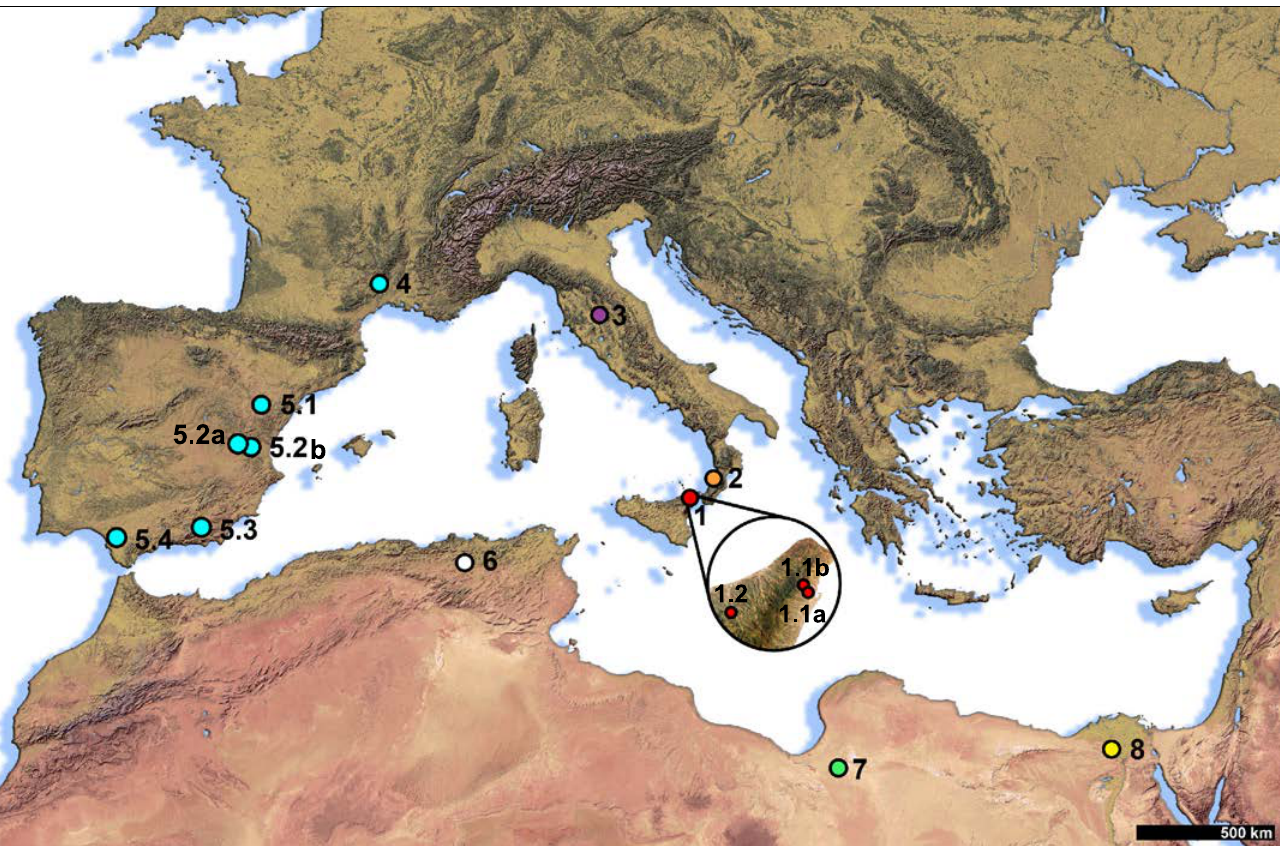
Fig. 1. Selected records of circum-Mediterranean hippopotamids during the latest Miocene–earliest Pliocene. 1, Hexaprotodon ? siculus (Hooijer, 1946) (1.1a, Gravitelli and 1.1b Scirpi; San Pier Niceto) Messina, Sicily, late Miocene; 2, ?Hippopotamidae indet., Cessaniti, Calabria, late